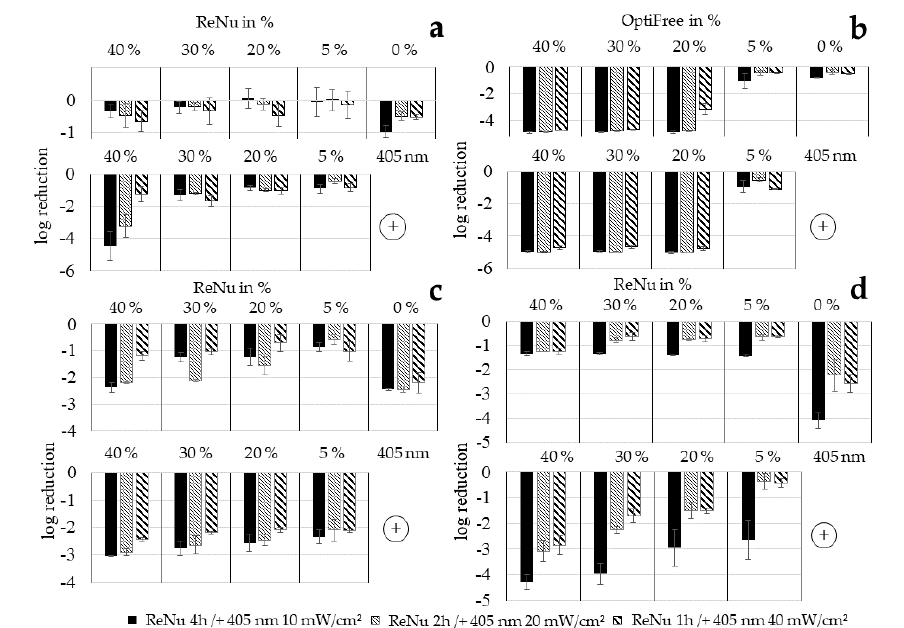
Figure 6. Log reductions determined from growth delay analysis for di ff erent intensities of 405 nm light and di ff erent concentrations of disinfection solutions: ReNu Multiplus on P. fluorescens ( a ), OptiFree Express on P. fluorescens ( b ), ReNu Multiplus on E. coli ( c ) and ReNu Multiplus on S. carnosus ( d ). Upper part of diagram presenting results for single approaches, lower part presenting combination results ( + ). Error bars indicate the deviation in the three